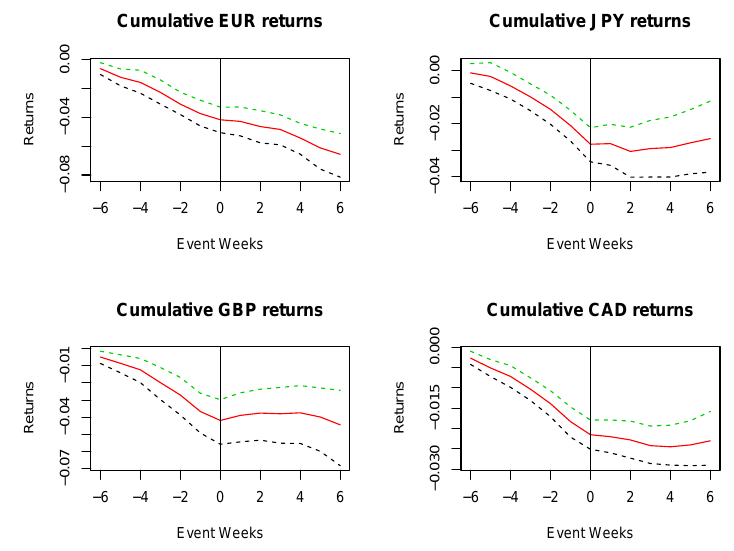
Figure 3. Event Study: Extreme (90th percentile), Non-commercial net long (S1), six week window. Non-commercial net per OI (S2) are the net speculative positions (as reported to US regulator the CFTC) relative to all open positions; extreme high is at or above the 90th percentile for the whole range, cumulative returns are the sum of log exchange rate returns. The event day is the day of the extreme reading as a measure of extreme speculative activity. If speculation is uninformed, extremes should be followed by reversals; if speculation is informed, extremes are more likely to be followed by a random walk.